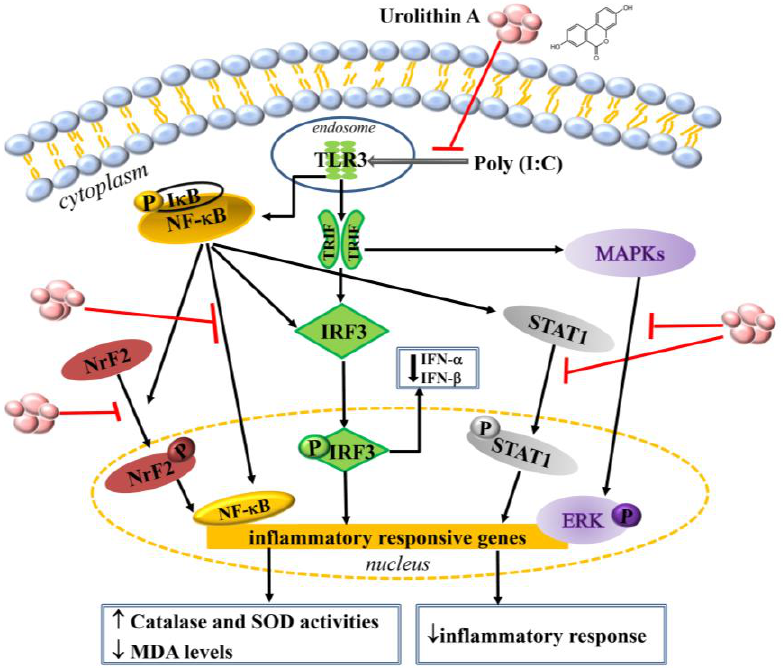
Figure 8. Model explaining the mechanisms of urolithin A ’ s attenuation of viral-induced inflamma- tion and oxidative stress in macrophages stimulated by poly(I:C).